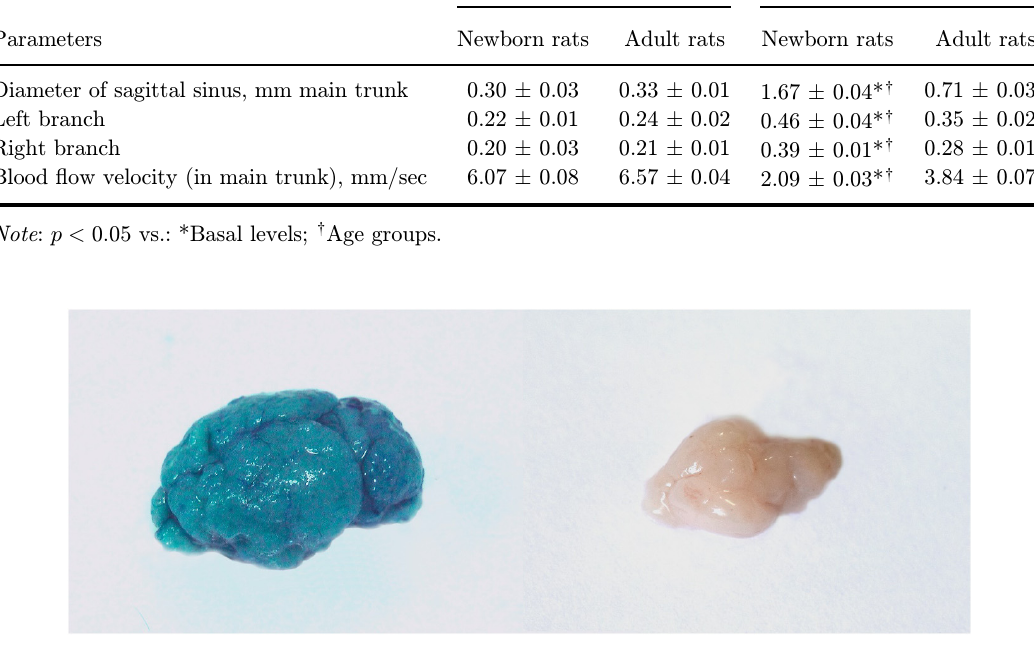
Fig. 3. The color test for the study of age di®erences in the stroke-induced breakdown of BBB permeability with using Evans blue injection. The leakage of Evans Blue is in adult but not in newborn rats.